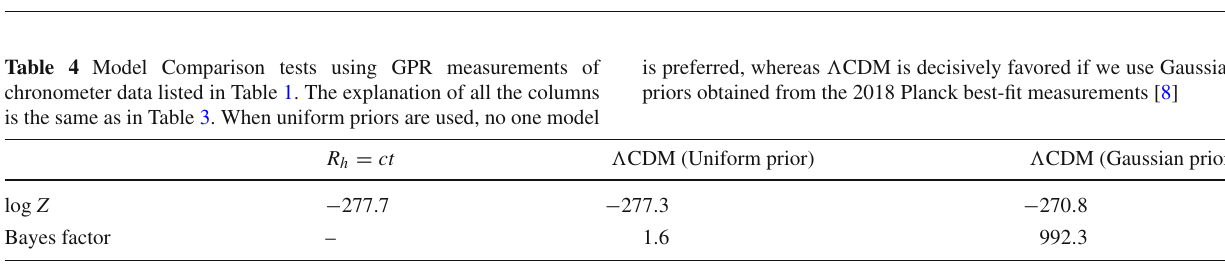
R h = ct universe model. When uniform priors are used for (cid:2) CDM, the Bayesian evidence for the two models are almost identical, with no one model been preferred. When we used Gaussian priors centered on the Planck best-fit values [8], (cid:2) CDM is very strongly preferred over